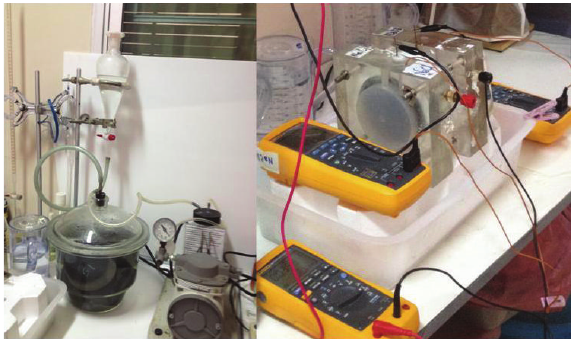
Figure 1: The RCPT test setup with ASTM C1202